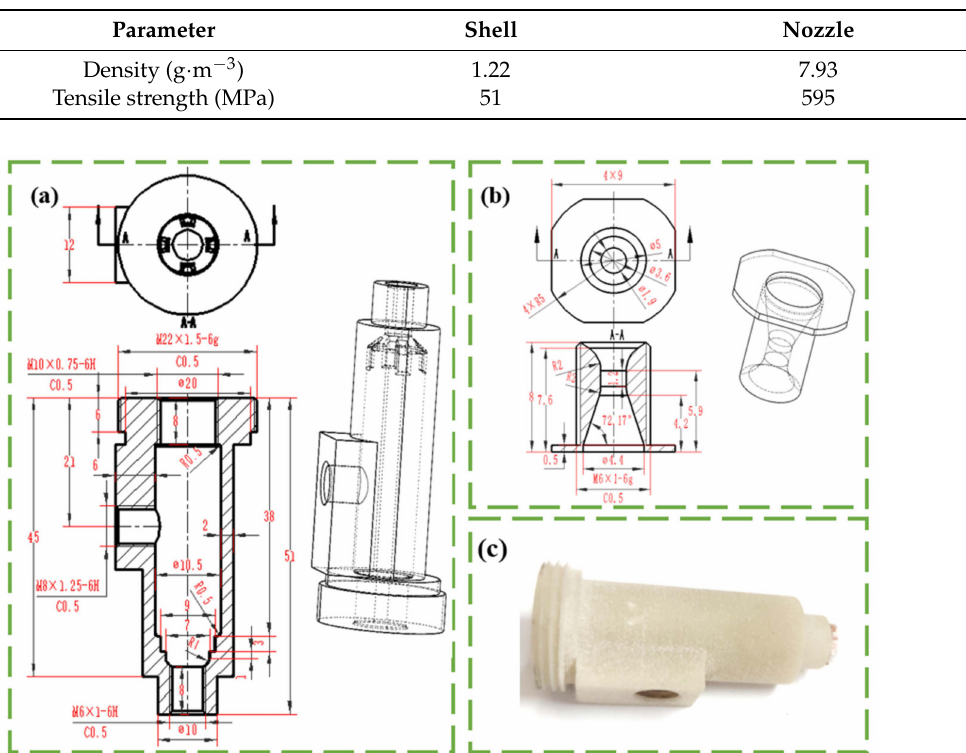
Table 1. Values of material parameters.